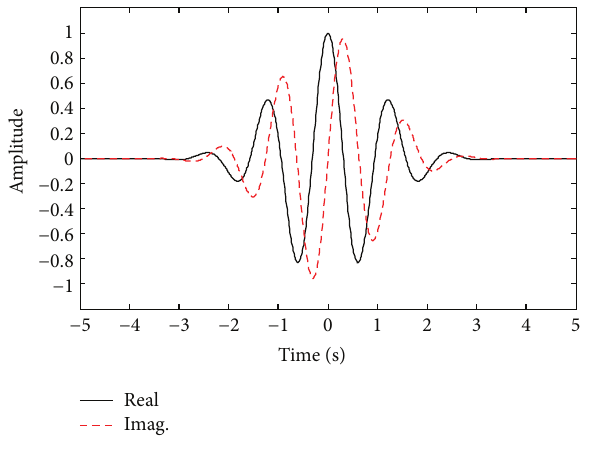
Figure 1: Morlet